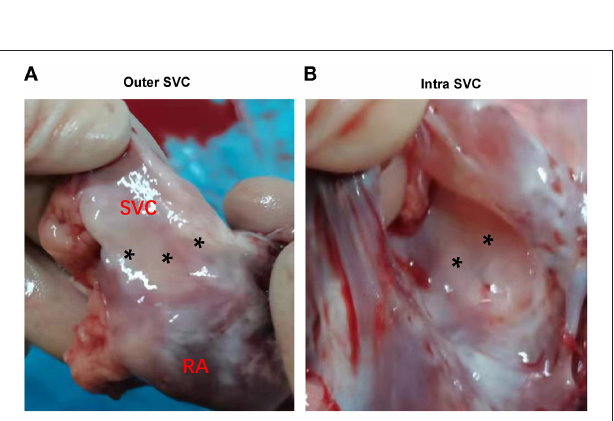
FIGURE 4 | Pacing threshold measuring. Before ablation, catheter in superior vena cava can record atrial potential and successfully pace the atrium. After ablation, PFA catheter in superior vena cava could not record the atrial electrical activity and pacing the atrium. PFA, Pulsed field ablation.